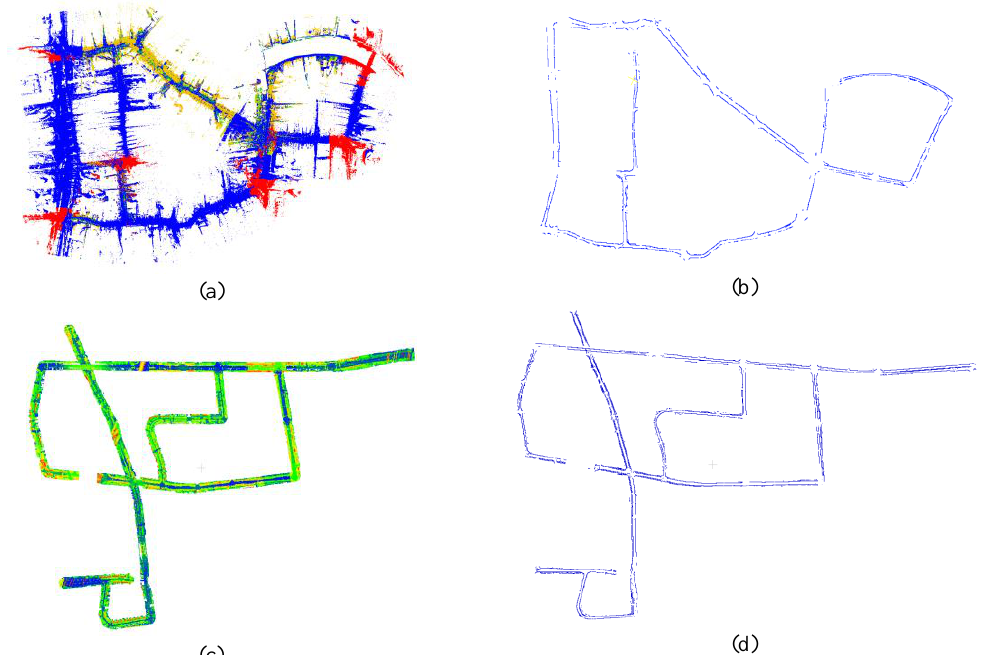
Figure 6. Curbs extracted from two experimental datasets: (a) Xinchang residential district, Shanghai dataset; (b) extracted result of XinChang dataset; (c) Zhangjiang industrial district, Shanghai dataset; (d) extracted result of Zhangjiang